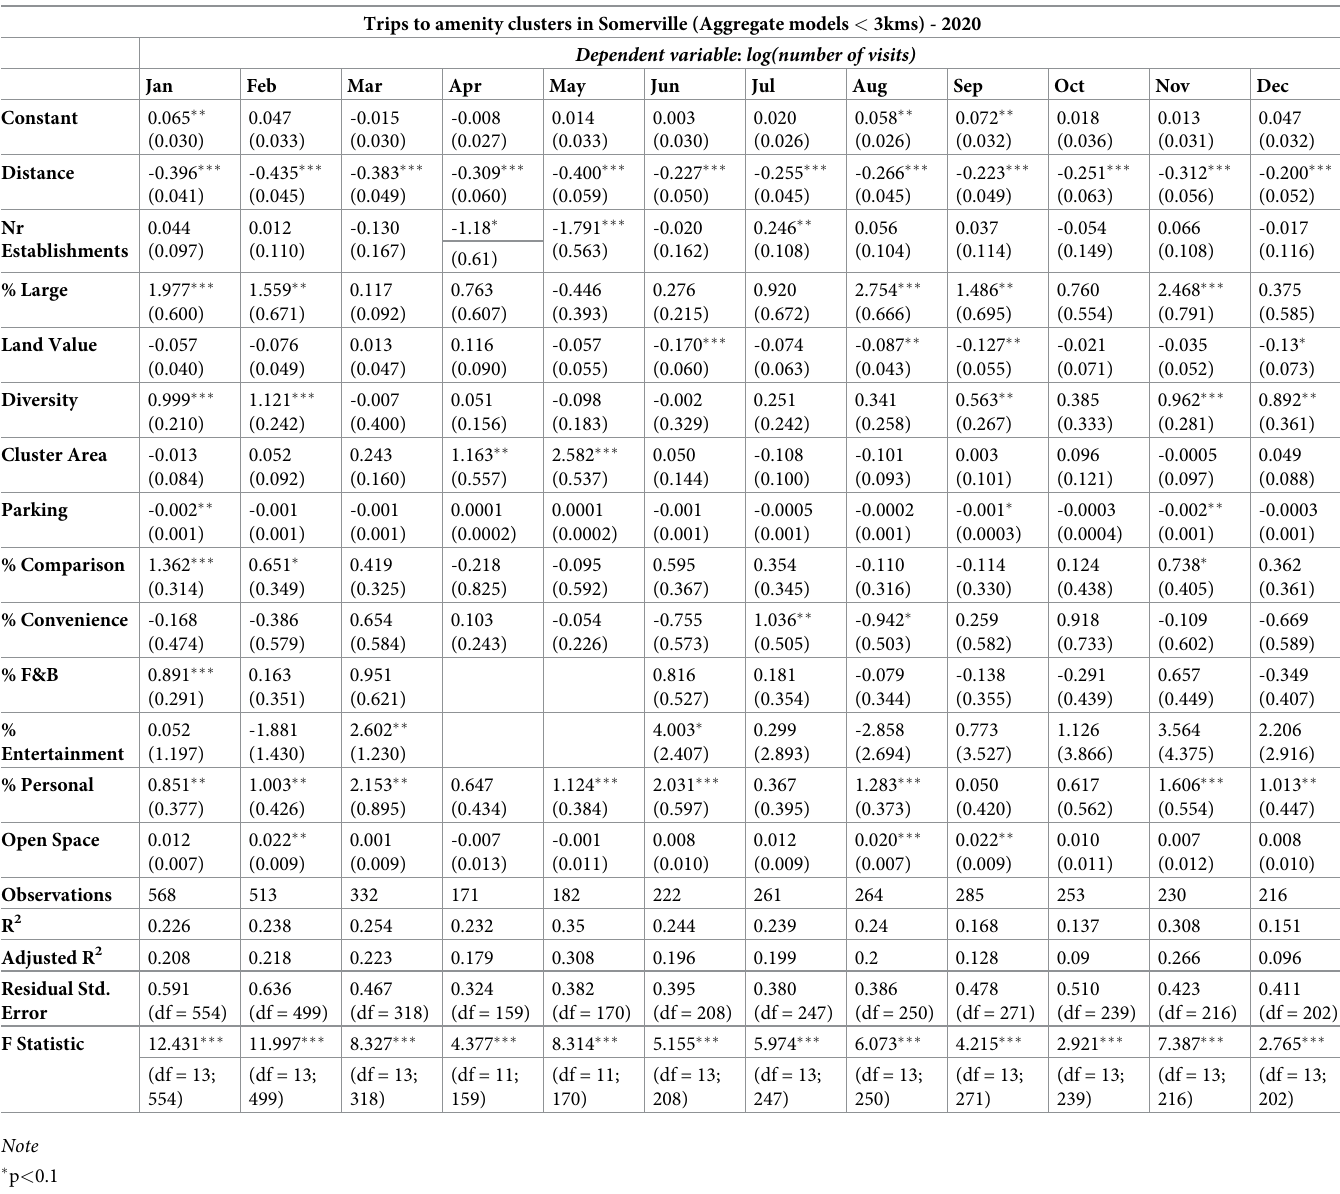
Table 3. Model results for all CBGs, for trips up to 3km in length, in